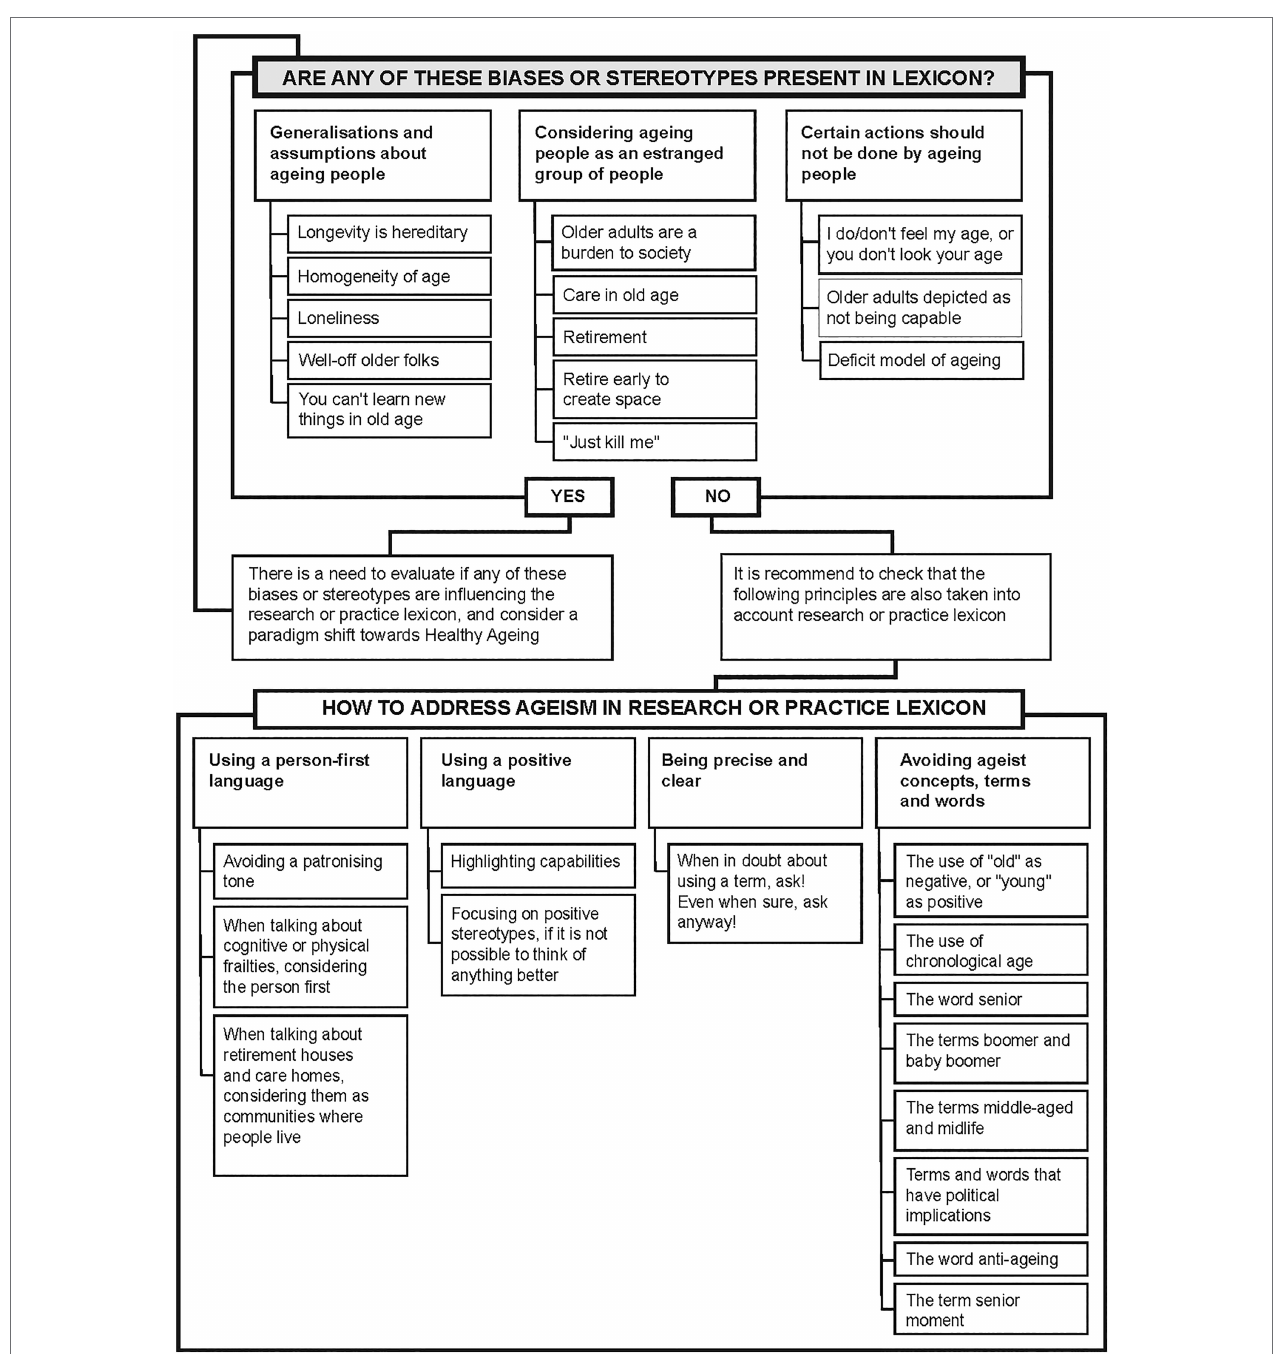
FIGURE 1 | Summary of the guidelines to promote the use of an appropriate lexicon about